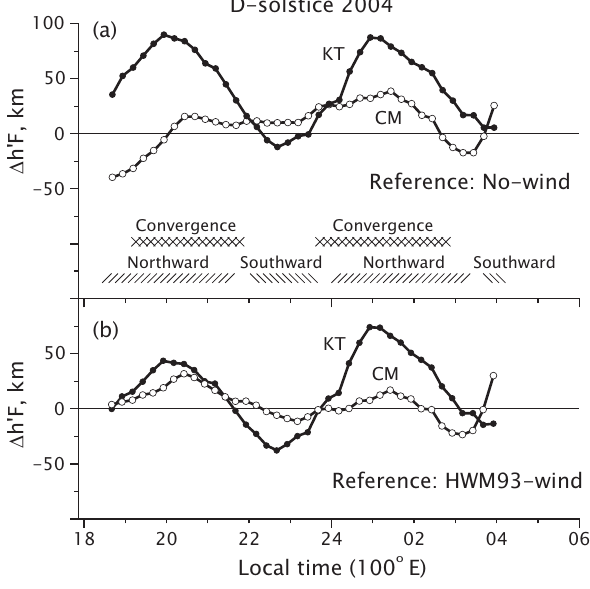
Fig. 6. Deviation of the observed bottom height (monthly median) from the modeled reference height without wind effect (a) and with the HWM93 wind model (b) for Kototabang (KT) and Chiang Mai (CM). In the lower part of panel (a), the meridional neutral wind inferable from the height deviations is